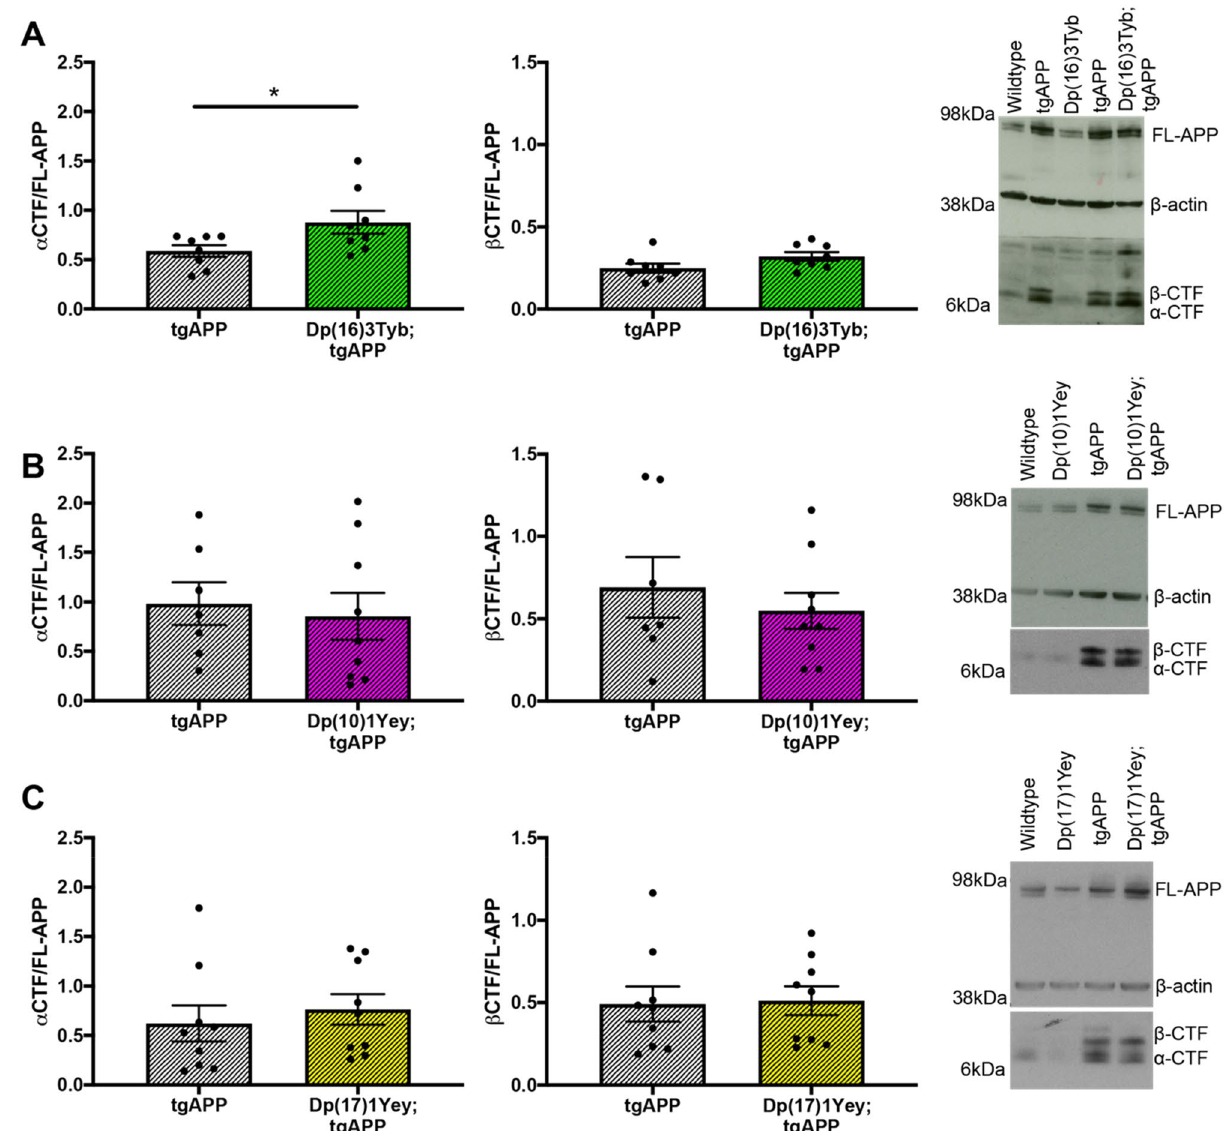
Figure 3. The effect of DS segmental duplication models on CTF abundance in the brain. ( A–C ) The relative abundance of APP β-C-terminal fragment (β-CTF) and APP α-C-terminal fragment (α-CTF) compared to full- length APP (FL-APP) was measured by western blot using A8717 primary antibody in the cortex at 3-months of age in female and male mice. ( A ) Significantly more α-CTF was observed in Dp(16)3Tyb;tgAPP (n = 8, 4 male and 4 female) than tgAPP (n = 8, 4 male and 4 female) controls (F(1,12) = 5.226, p = 0.041), β-CTF was not raised in this double mutant mouse (F(1,13) = 3.005, p = 0.107). ( B ) In Dp(10)1Yey;tgAPP mice (n = 11, 7 male and 4 female) neither α-CTF (F(1,12) = 0.143, p = 0.712) nor β-CTF (F(1,12) = 0.291, p = 0.599) abundance differed from tgAPP (n = 7, 3 male and 4 female) controls. ( C ) In Dp(17)1Yey;tgAPP (n = 9, 6 male and 3 female) mice neither α-CTF (F(1,13) = 0.350, p = 0.363) nor β-CTF (F(1,13) = 0.566, p = 0.465) abundance differed from tgAPP (n = 9, 3 male and 6 female) controls . Error bars show SEM, data points are independent